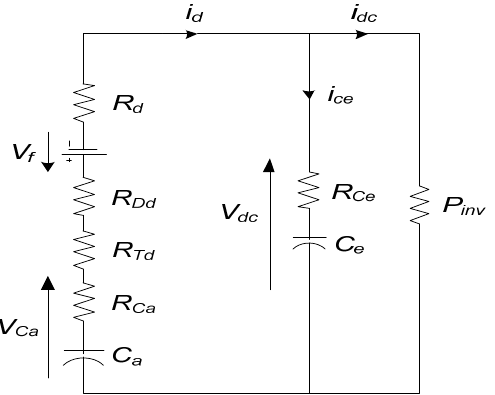
Figure 2. DC-link during compensation (discharge). Inrush current at start of compensation,